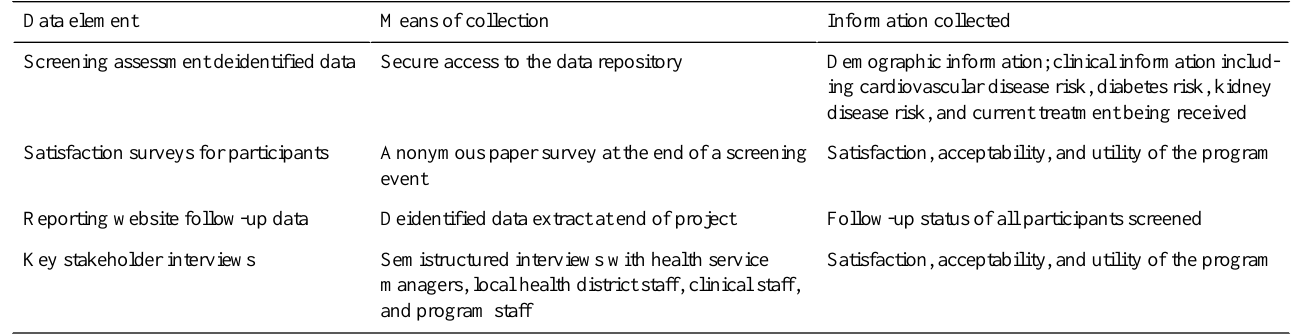
Table 1. Data elements for evaluation of the 1 Deadly Step program.